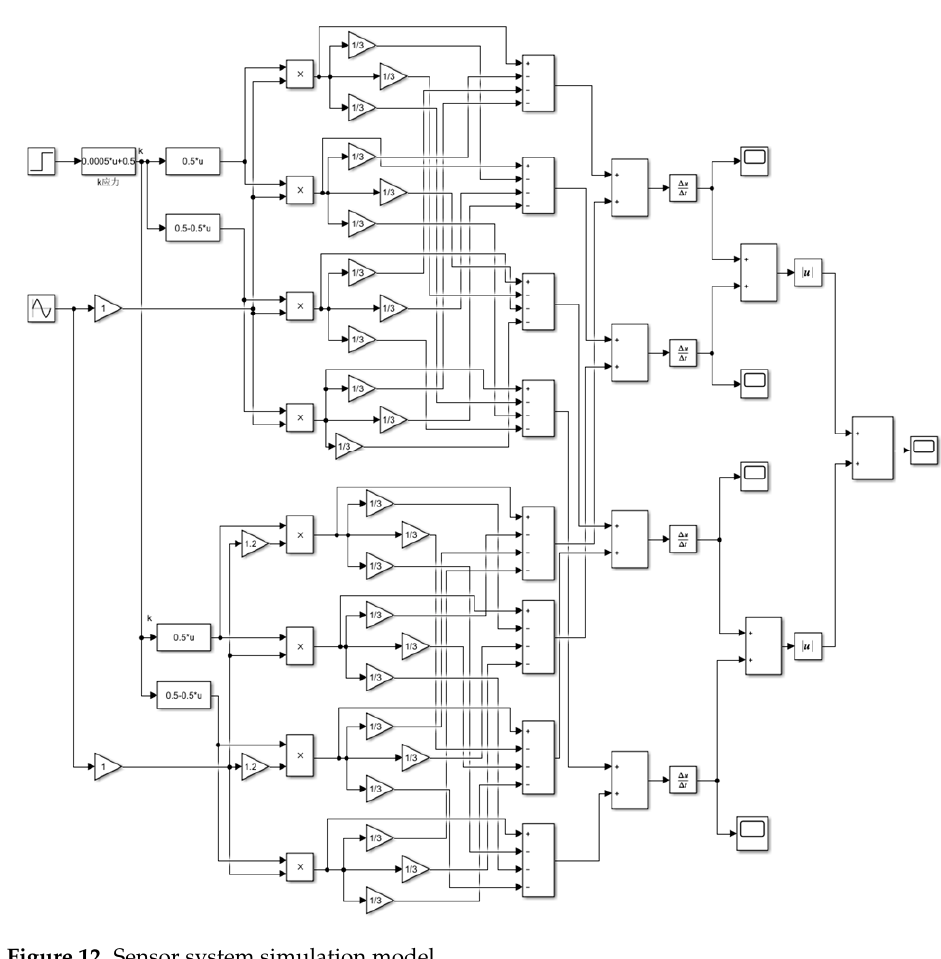
Figure 12. Sensor system simulation model.